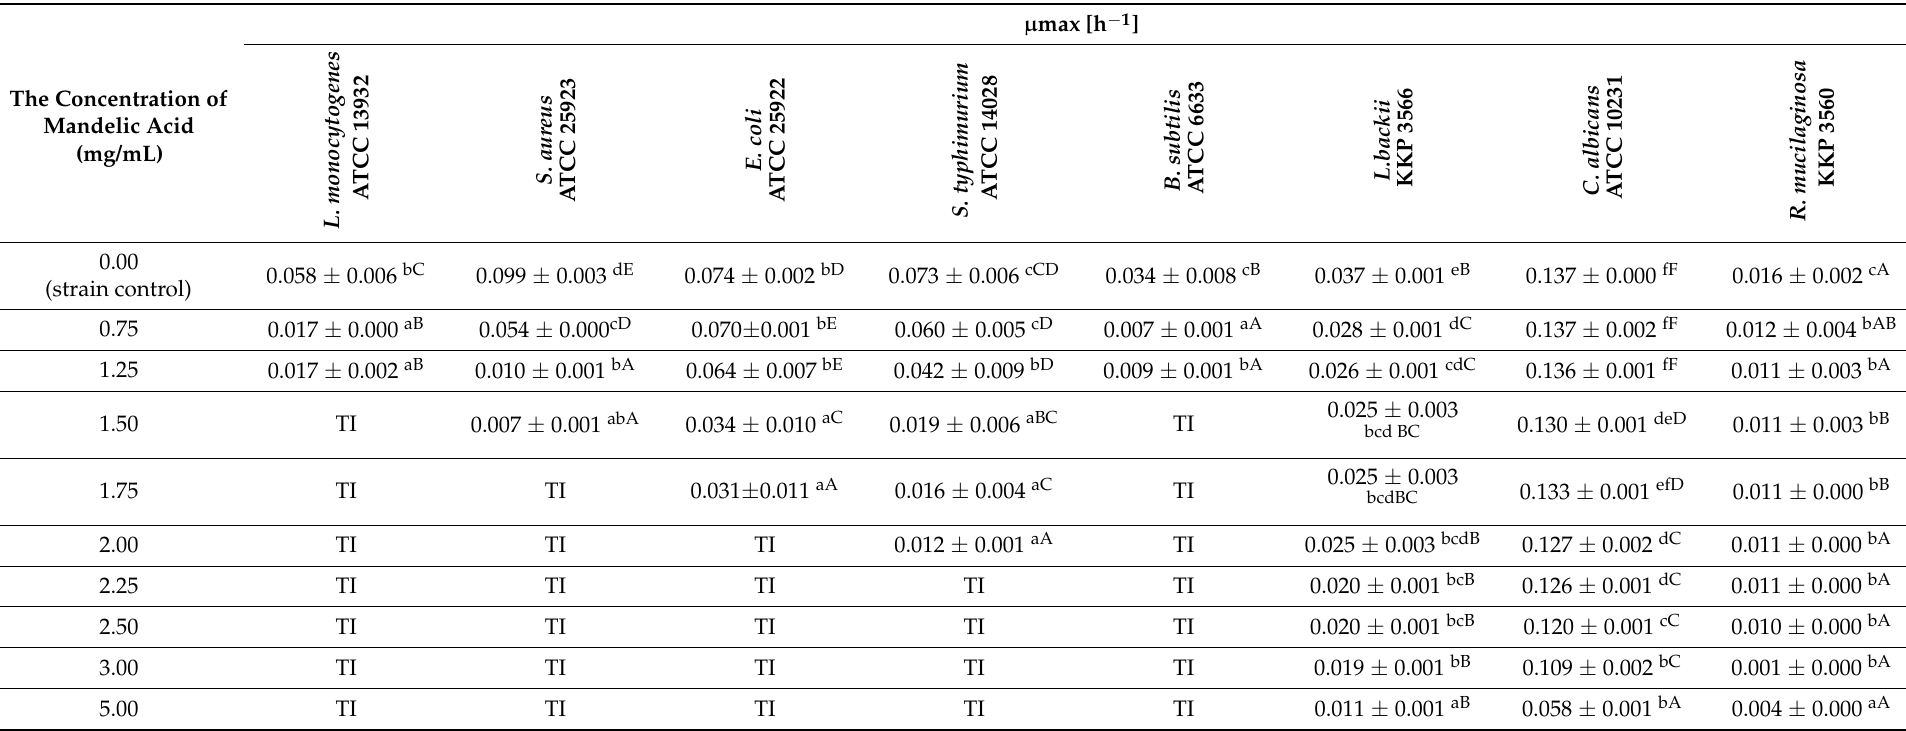
Table 8. The effect of mandelic acid on the maximum growth rate ( µ max ) of the tested strains—Gompertz analysis.